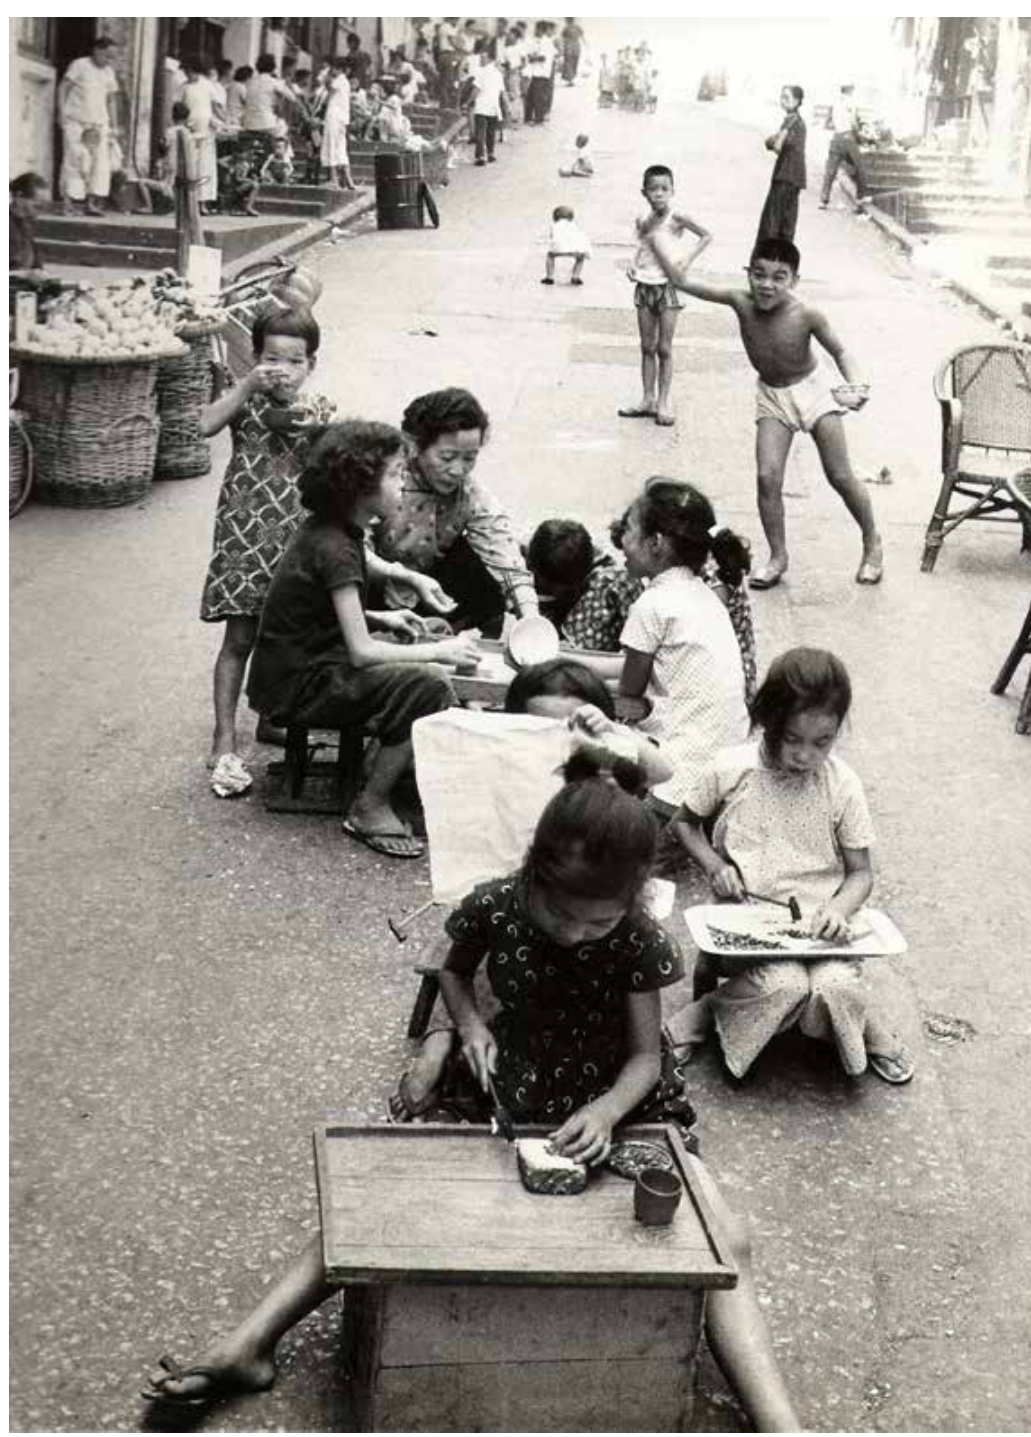
Figure 1: Nick Howard, Little Helpers,